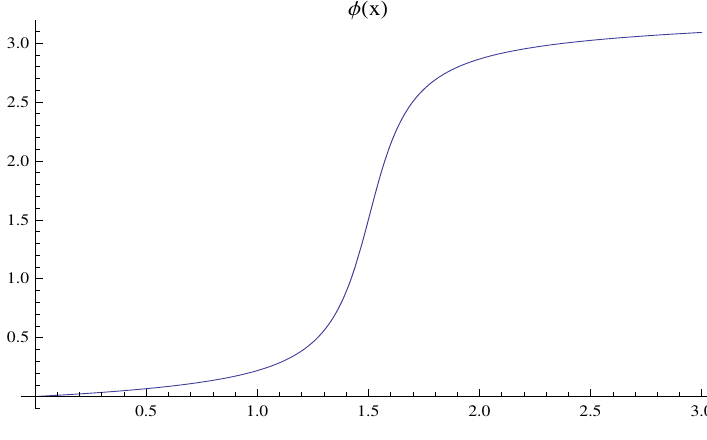
Figure A4. Plot of ϕ in a symmetric solution with ∆ ϕ (cid:39) 3.1, L = 3.